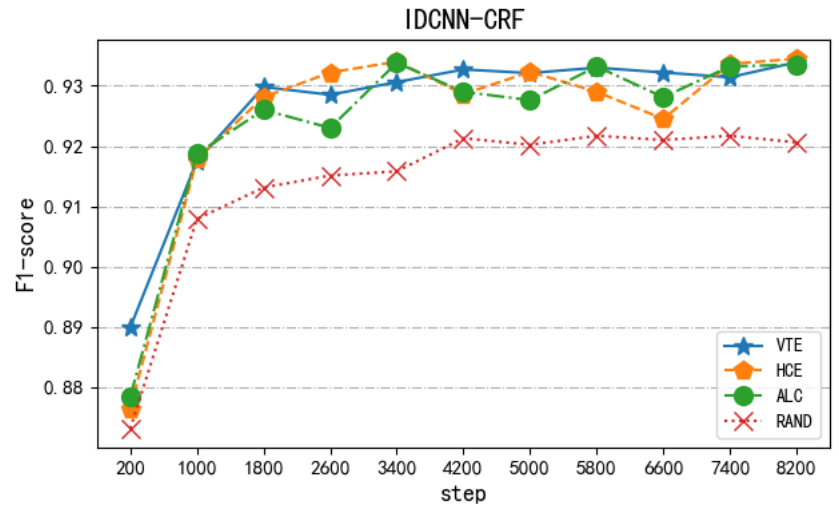
Figure 7. The performance of these algorithms based on IDCNN-CRF model.